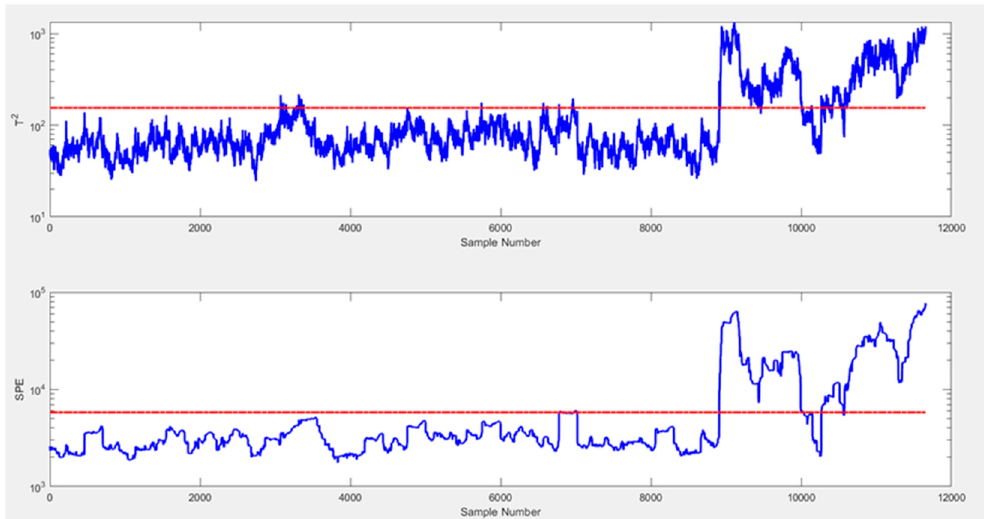
Figure 8. (cid:1846) 2 and Q for period C .